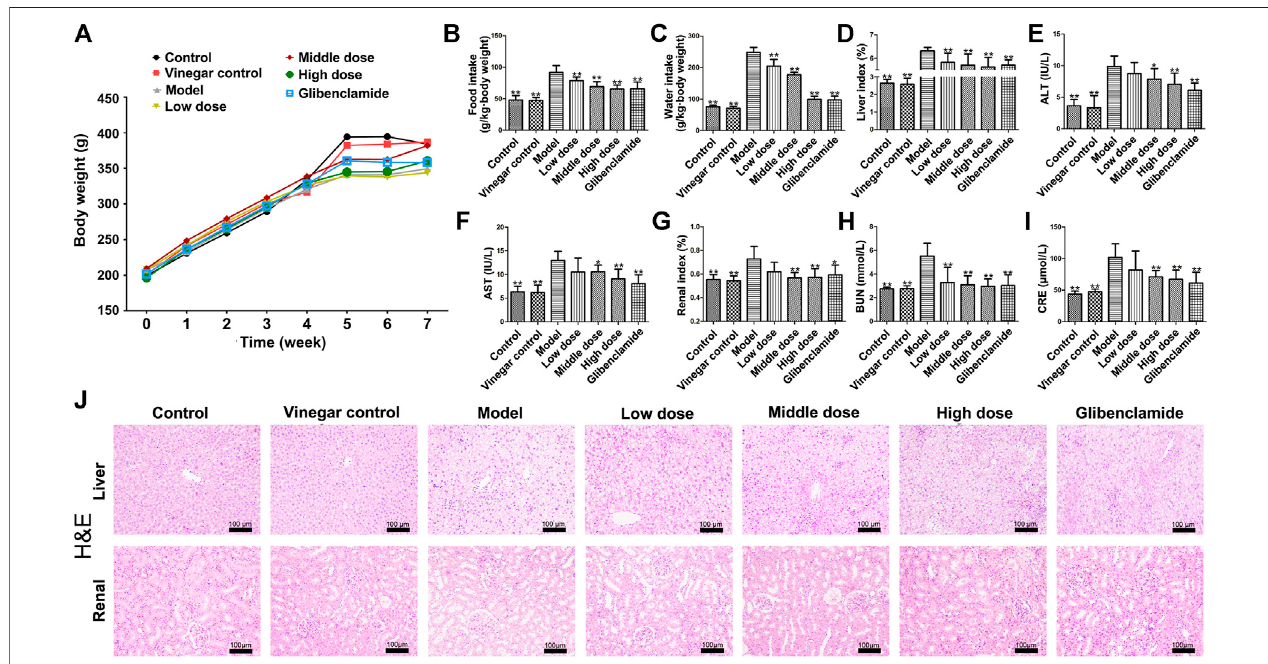
FIGURE 2| Effects of HSAV on general status and liver functions ofT2DM rats. (A) Body weight; (B) food intake; (C) water intake; (D) liver index; (E) ALT; (F) AST; (G) renal index; (H) BUN; (I) CRE; (J) H&E staining of liver and renal tissue. Data are presented as the mean ± SD (n (cid:2) 10). * p < 0.05 and ** p < 0.01 compared with model